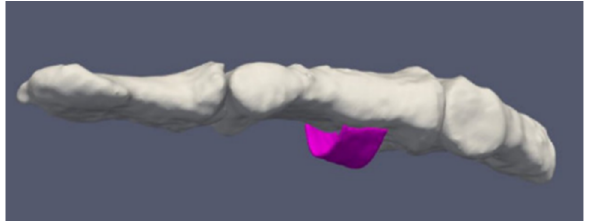
Figure 3. Three-dimensional rendering of the human index finger model showing the bone structure only and pulley A4.